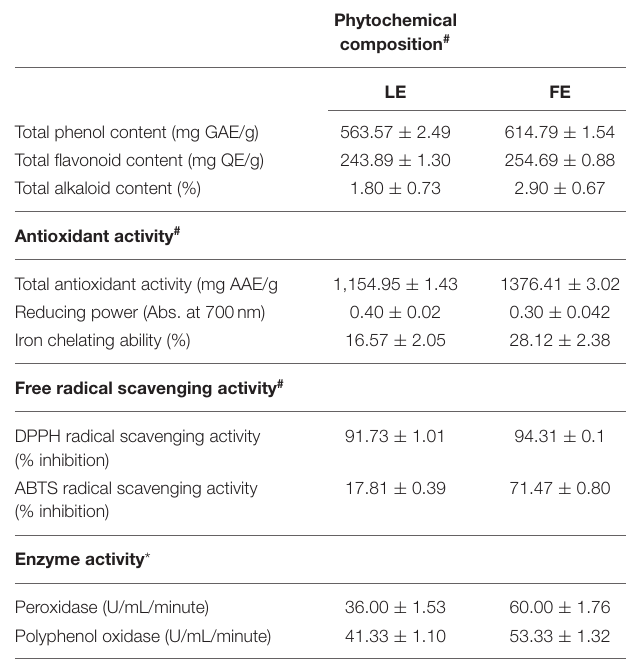
* Enzyme activity values represented in above table is mean values of duplicates. Data are expressed as mean ± SD of 3 replicates. # Indicate that the experiments were performed in